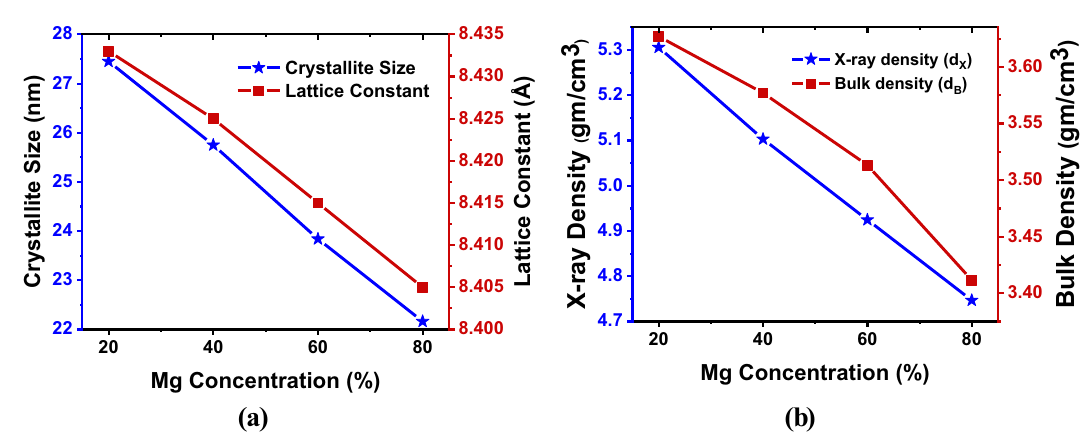
Figure 5. Variation ( a ) crystallite size and lattice constant and ( b ) X-ray density and bulk density of the prepared MgZnFe 2 O 4 samples with different Mg